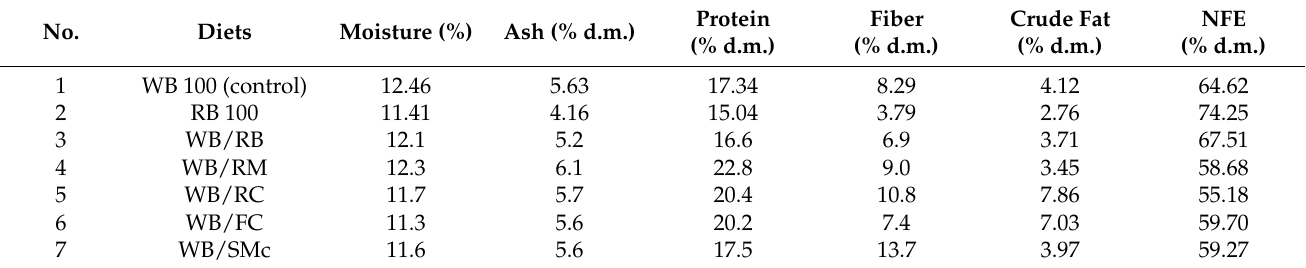
Table 2. Proximate composition of experimental diets and